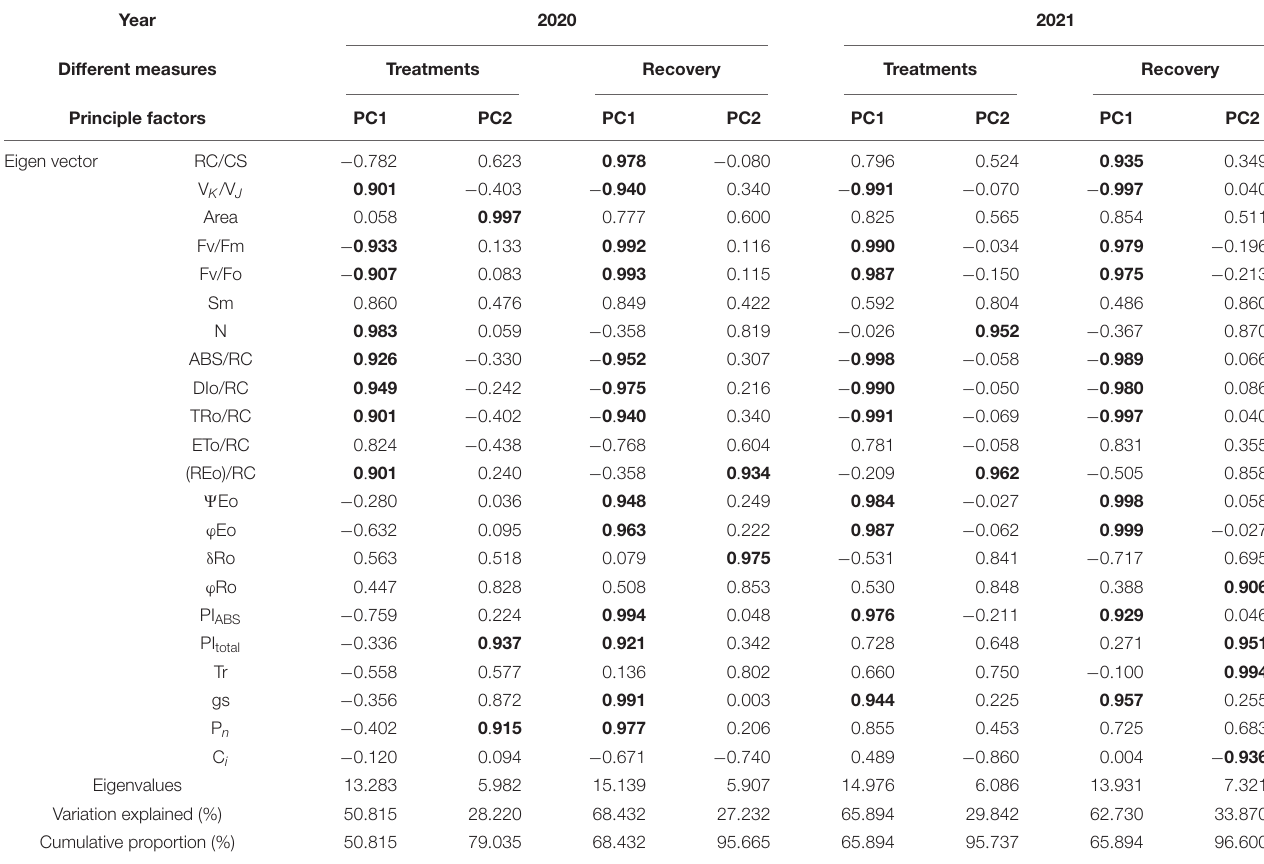
TABLE 4 | The results of principal component analysis